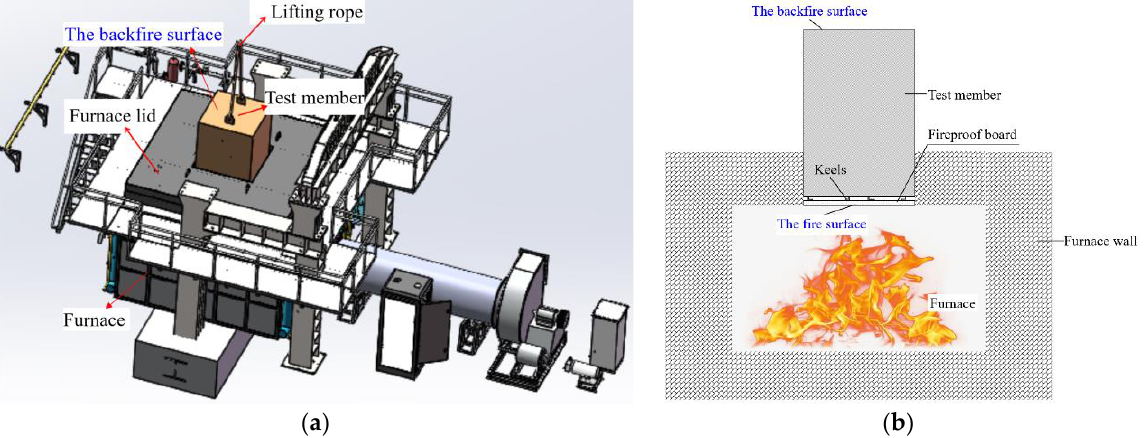
Figure 2. Schematic of fire test on a structural member. ( a ) Schematic diagram of the tube structure under fire at the unilateral side; ( b ) front view of the tube structure under fire at the unilateral side.